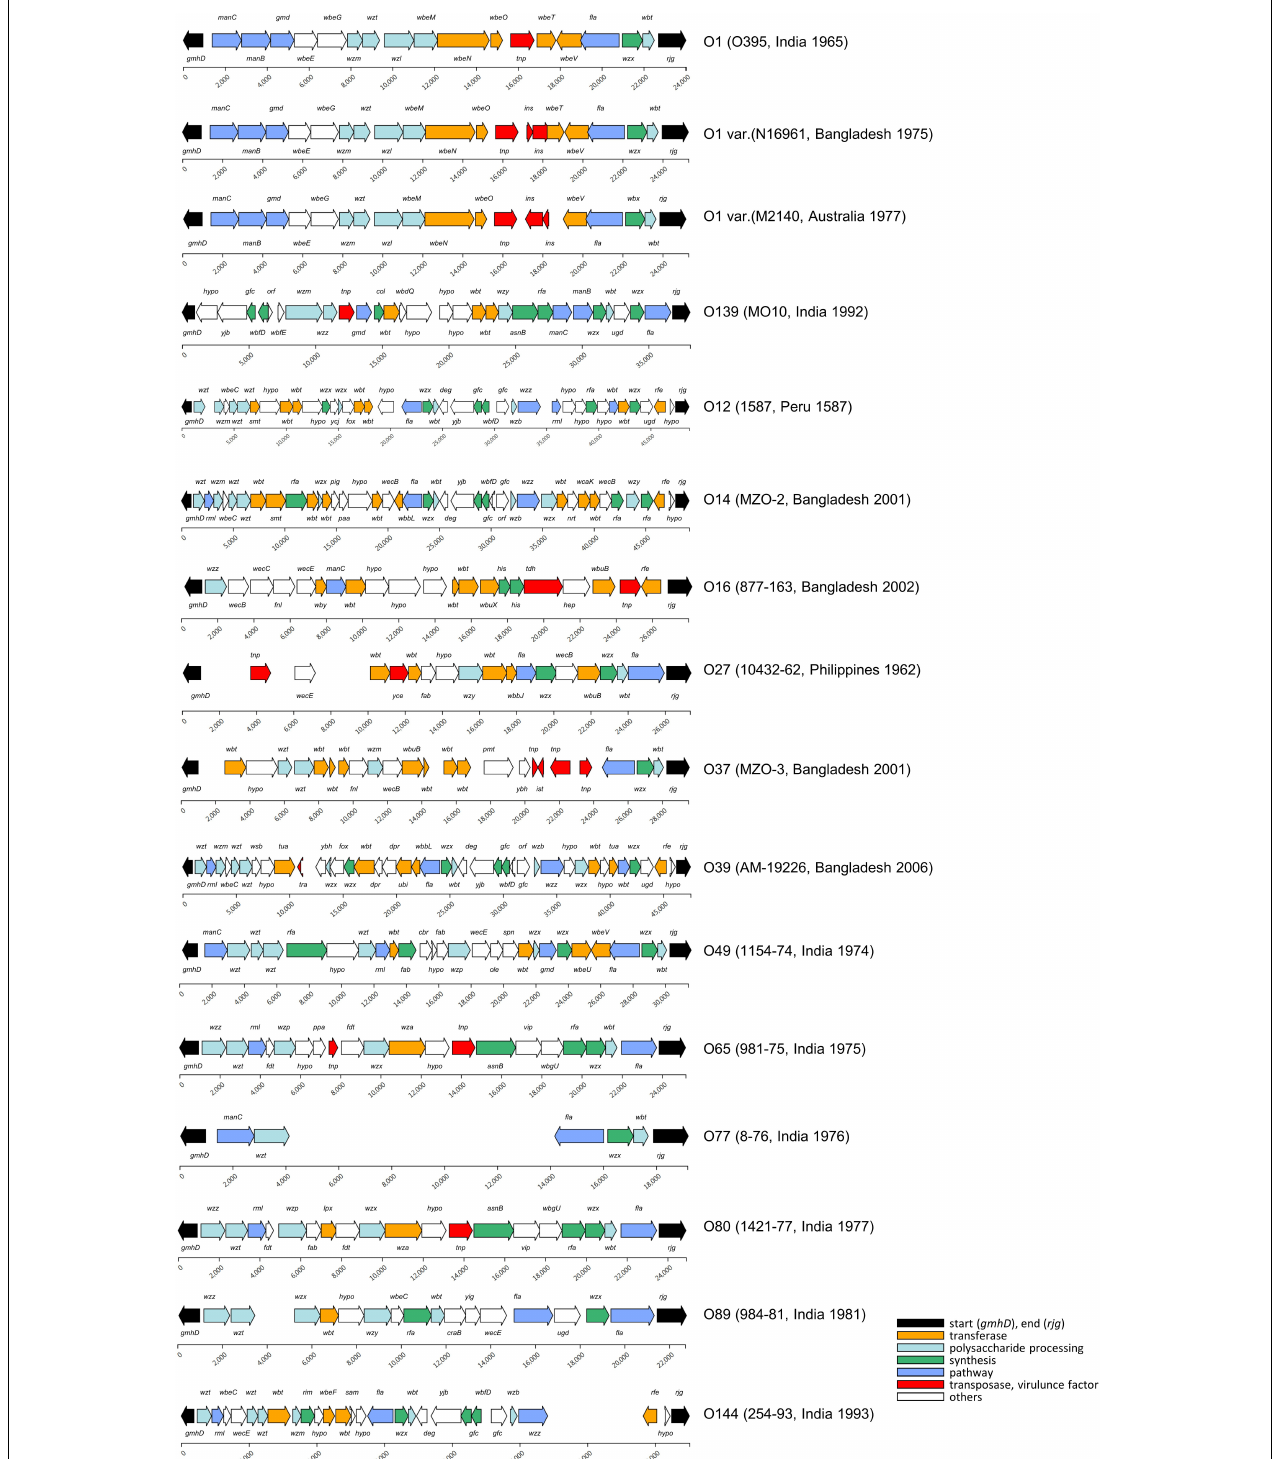
FIGURE 2 | O-antigen gene cluster of the V. cholerae strains. A total of 14 known O serogroups and 35 non-O1/O139 were analyzed in this study. Most of the OAGC structures of the O1 serogroup were the same as that of O395, and the structural variants in the O1 serogroups were found at the 13th–15th CDS of the OAGC. The sources of the structural variants were mainly an insertion of mobile elements. The OAGC structures of O139 were mostly the same as that of MO10. The blank space indicates the genomic region where no CDS was assigned from the prodigal program.